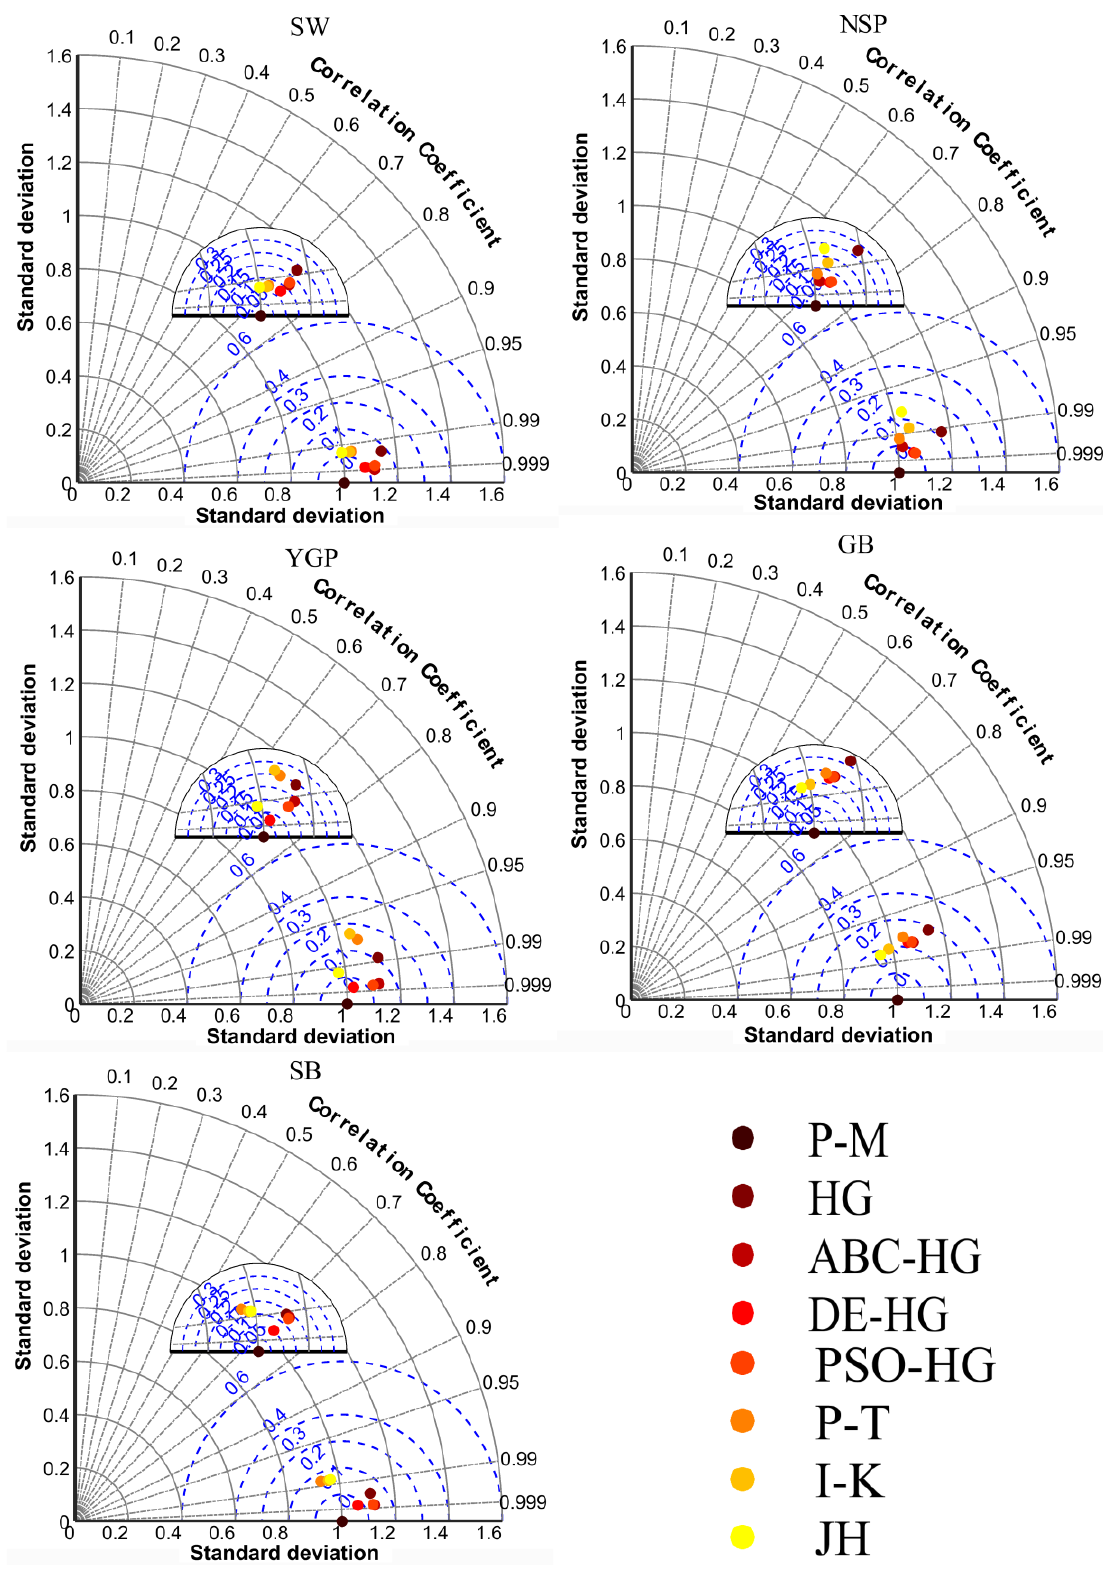
Figure 7. Taylor diagram of estimated monthly ET 0 accuracy in Southwest China and 4 districts based on HG model calibrated by ABC, DE, and PSO algorithms and 4 empirical models. Note: HG , PT, IA and JH represent Hargreaves, Priestley–Taylor, Imark–Allen and Jensen–Hais, respectively. NSP: Northwest Sichuan Plateau; GB: Guangxi Basin; SB: Sichuan Basin; YGP: Yunnan–Guizhou Plateau.